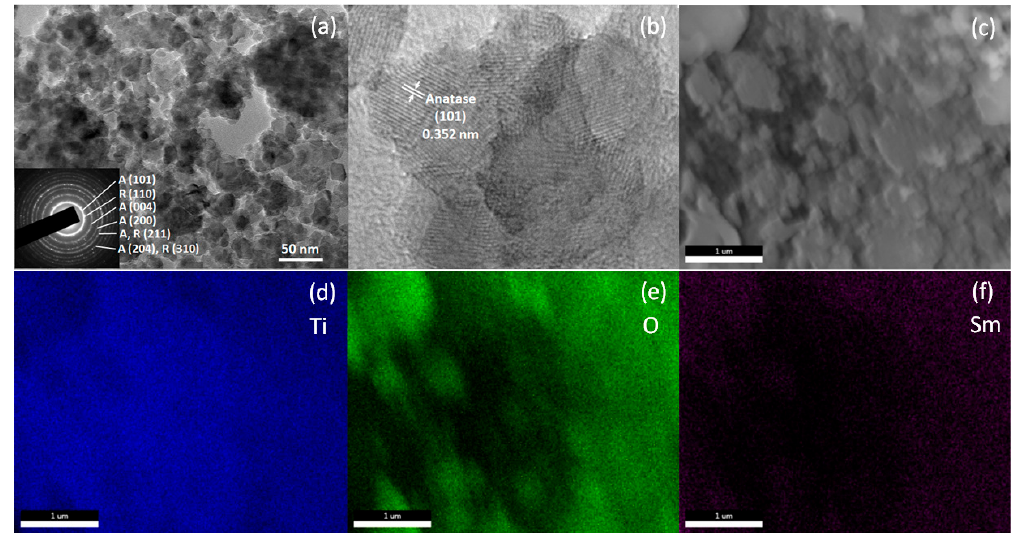
Figure 3. Bright field TEM ( a ); HRTEM ( b ); and SEM image ( c ) of Sm-C-TiO 2 with the corresponding elemental distribution maps ( d – f ). The inset shown in ( a ) is the diffraction pattern of the particles.